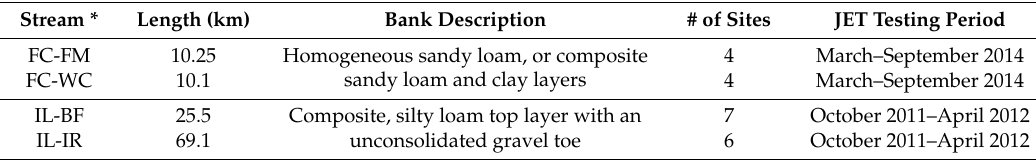
Table 1. Characteristics of streams selected for jet erosion